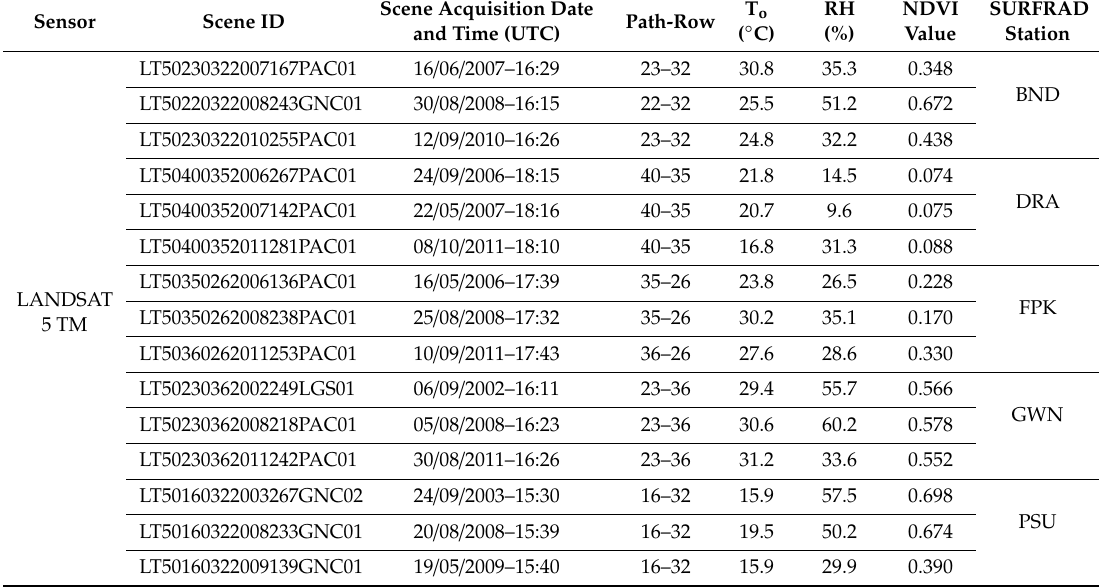
Table A1. Information about Landsat data used in the study (45 images from 2000 to 2019). The last column shows the SURFRAD station included within the satellite scene. SURFRAD codes can be found in: https: // www.esrl.noaa.gov / gmd / grad / surfrad / sitepage.html or in Table A1. Sensor Scene